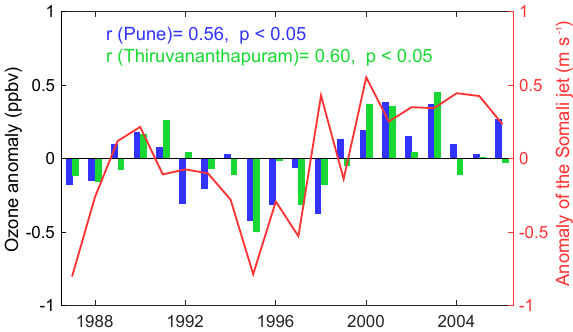
Figure 17. Interannual variation of the anomaly of the strength of the Somali jet and ozone from SHAF at two Indian sites, Pune and Thiruvananthapuram, in the lower troposphere in NH summer from 1987 to